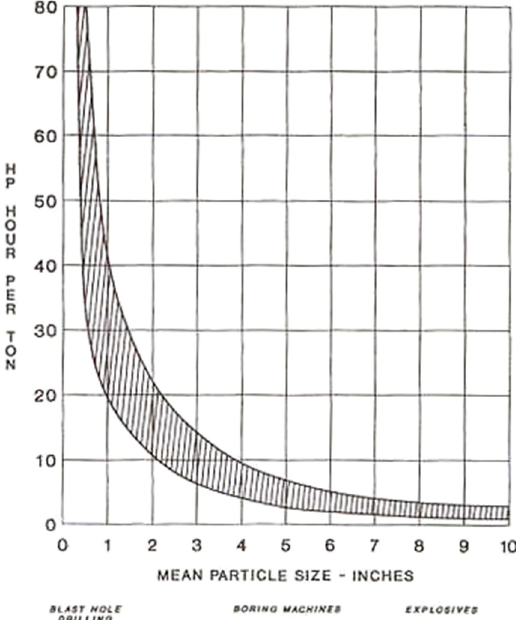
Figure 20. Correlation between the energetic cost of excavation of the rock, expressed in CV h/t, and the average size of the fragments obtained, expressed in inches. The “ranges” designate: “Blast Hole Drilling”: drilling of blast holes; “Boring Machines”: machines for the mechanical excavation of tunnels or shafts; “Explosives”: blasting. The highest energy cost is linked to the drilling operation, which forces a small volume of rock (equal to the product of the drilling diameter by the length of the hole) to be reduced to a very fine grain size. On the other hand, the explosive is the operation that requires the lowest energy cost compared to all the other techniques of “mechanical excavation”, since the result of the blast generally gives rise to blocks with a rather coarse size [25].